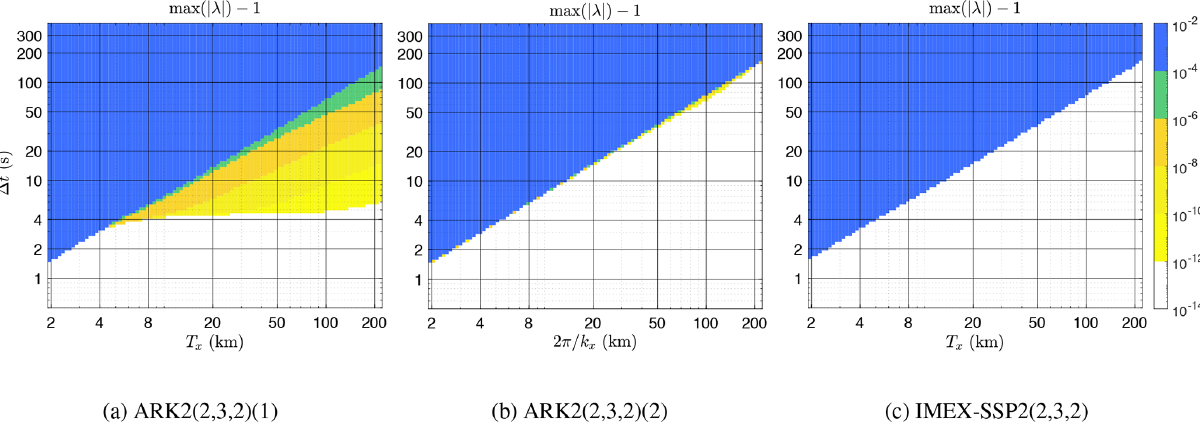
Figure 3. Schemes analyzed in Rokhzadi et al. (2018) and the ARK2(2,3,2)(2) scheme: (a) ARK2(2,3,2)(1), (b) ARK2(2,3,2)(2), and (c)